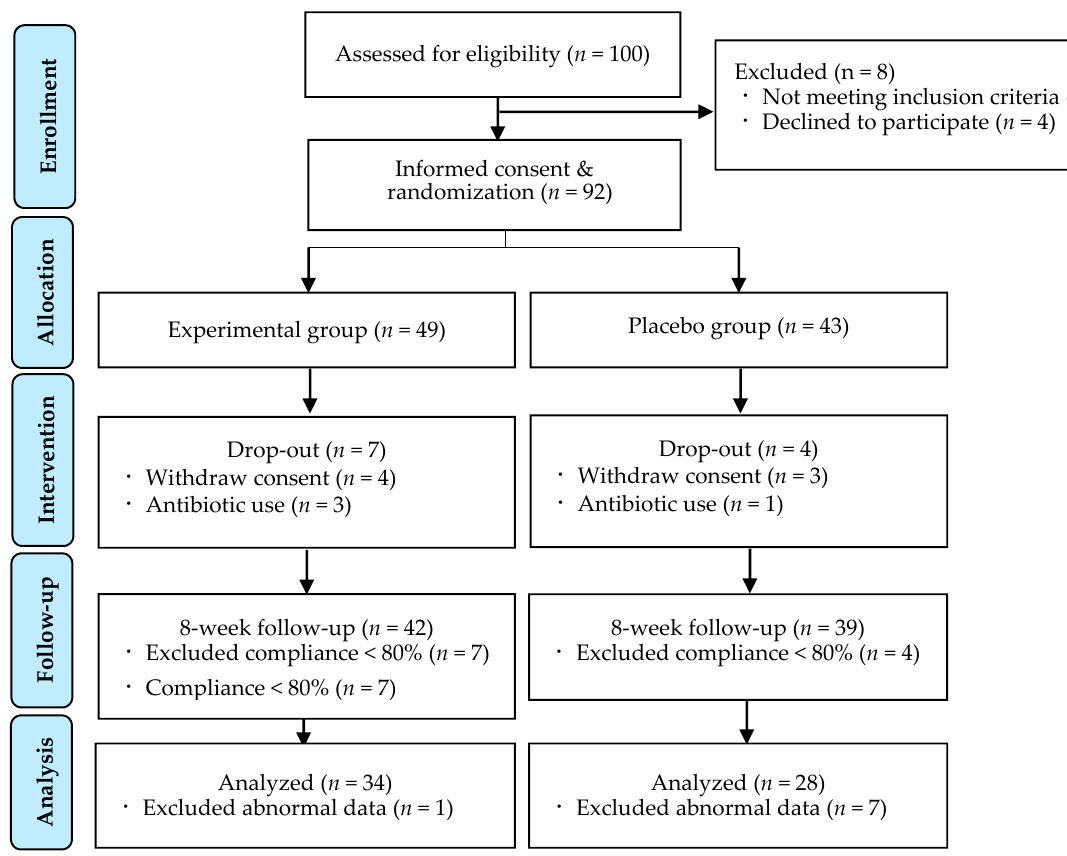
Figure 1. Research flow diagram.